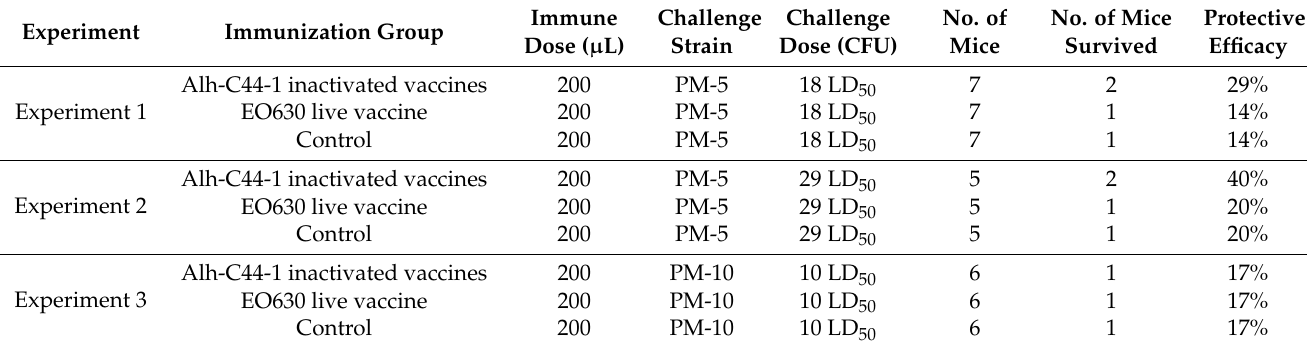
Table 2. Immune protection afforded by traditional vaccines against P. multocida serogroup A